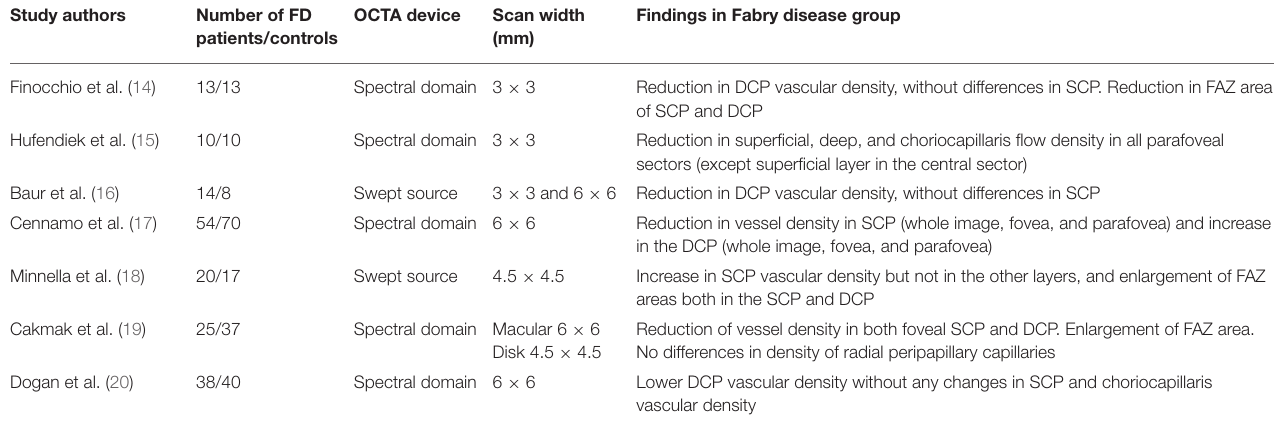
TABLE 4 | Studies reported in literature regarding optical coherence tomography angiography in patients affected by Fabry disease. Study